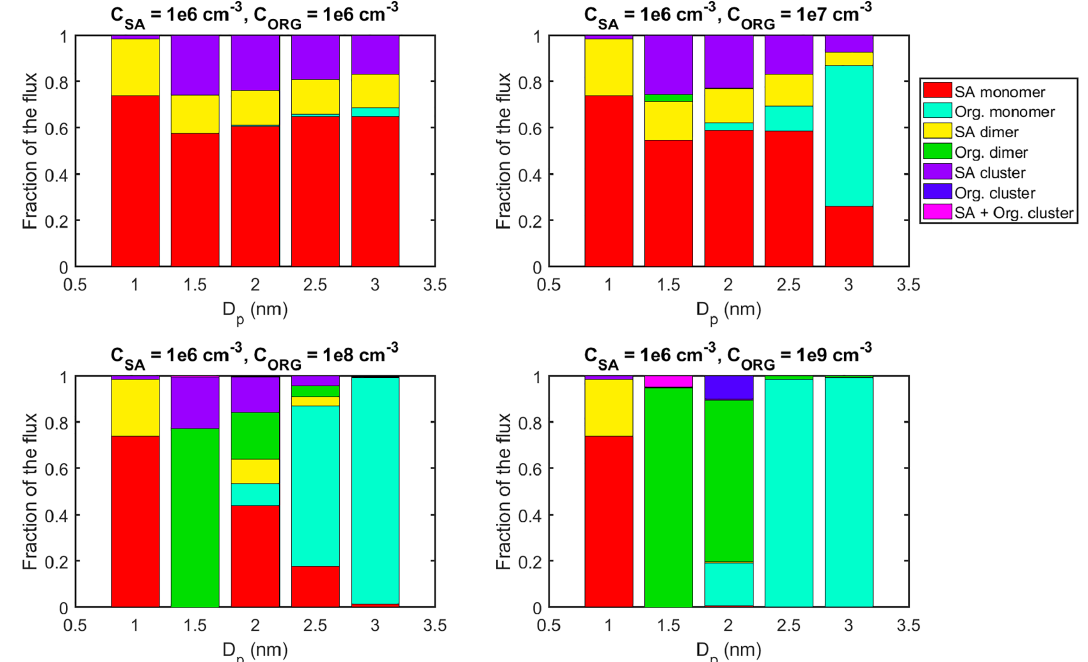
Figure A5. Contribution of different vapor monomers and clusters to the net flux past certain threshold sizes in simulations with SA–DMA and an organic compound with p sat = 10 − 8 Pa and m = 600amu (LVOC large ) at C SA = 10 6 cm − 3 and C ORG = 10 6 –10 9 cm − 3 . The values are at steady state.